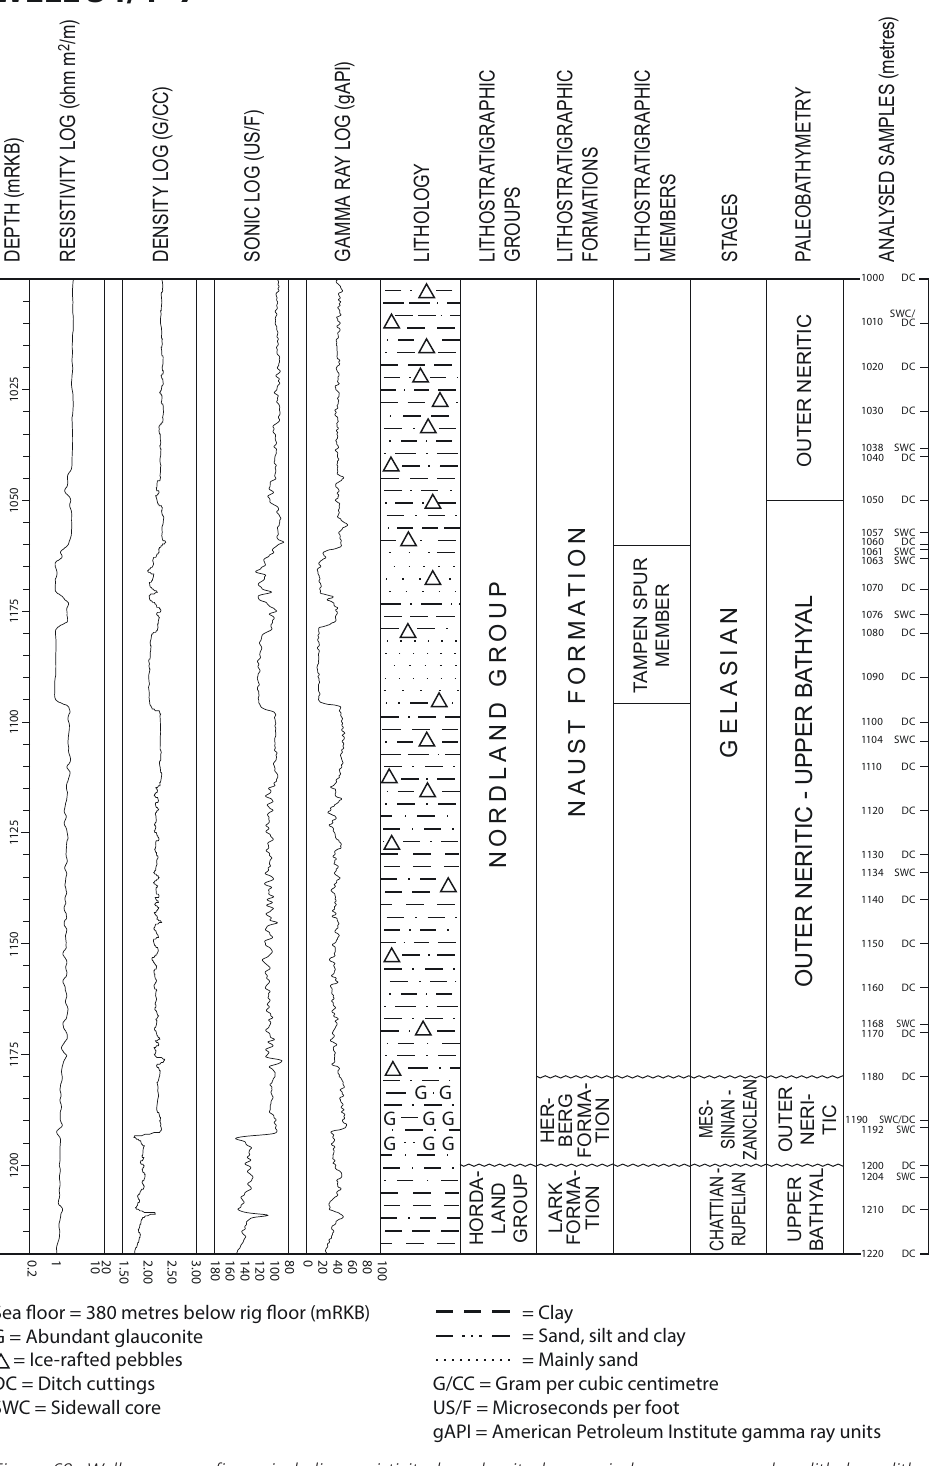
Figure 69. Well summary figure including resistivity log, density log, sonic log, gamma-ray log, lithology, litho- stratigraphic units, sub-series, stage, paleobathymetry and analysed samples for the investigated sequence in well 34/4–7 (lower/upper Oligocene to Gelasian) including the well type section for the Tampen Spur member (modified after Eidvin & Rundberg, 2001; Eidvin et al.,